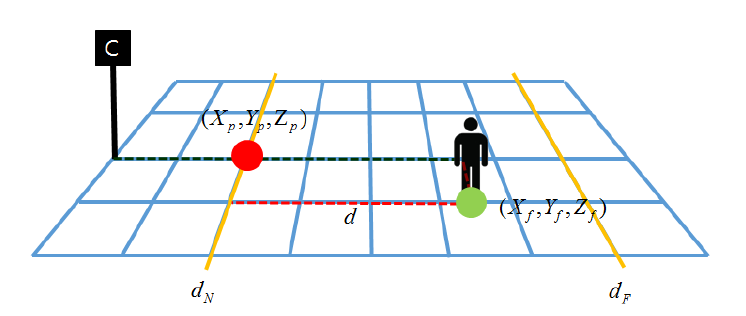
Figure 6. The proposed object depth estimation